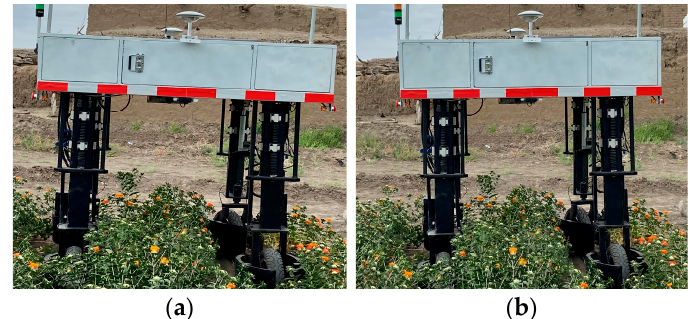
Figure 9. Mobile platform inclination. ( a ) Before levelling. ( b ) After levelling.